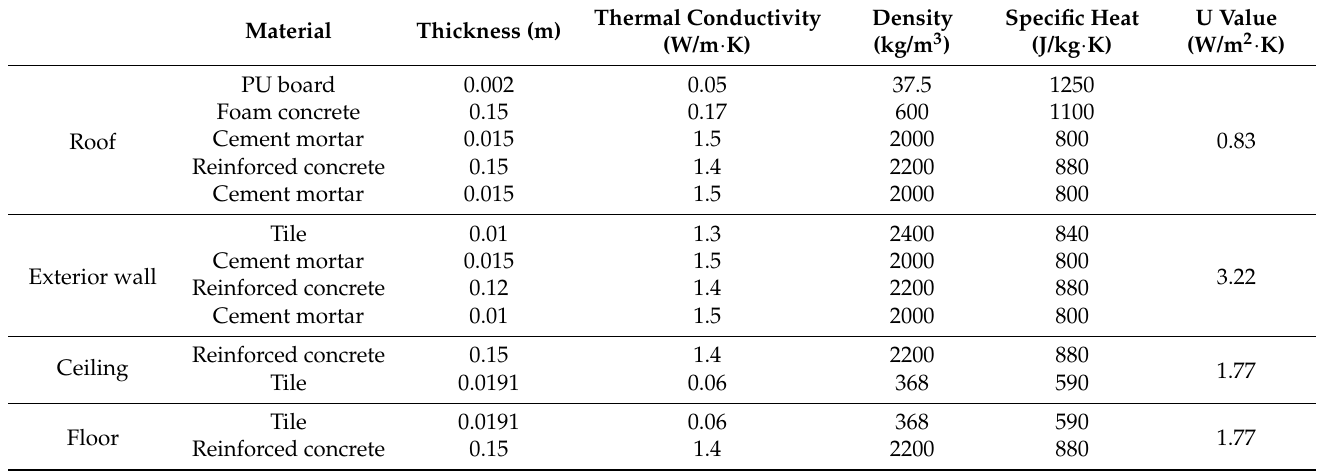
Table 9. Material settings for the office